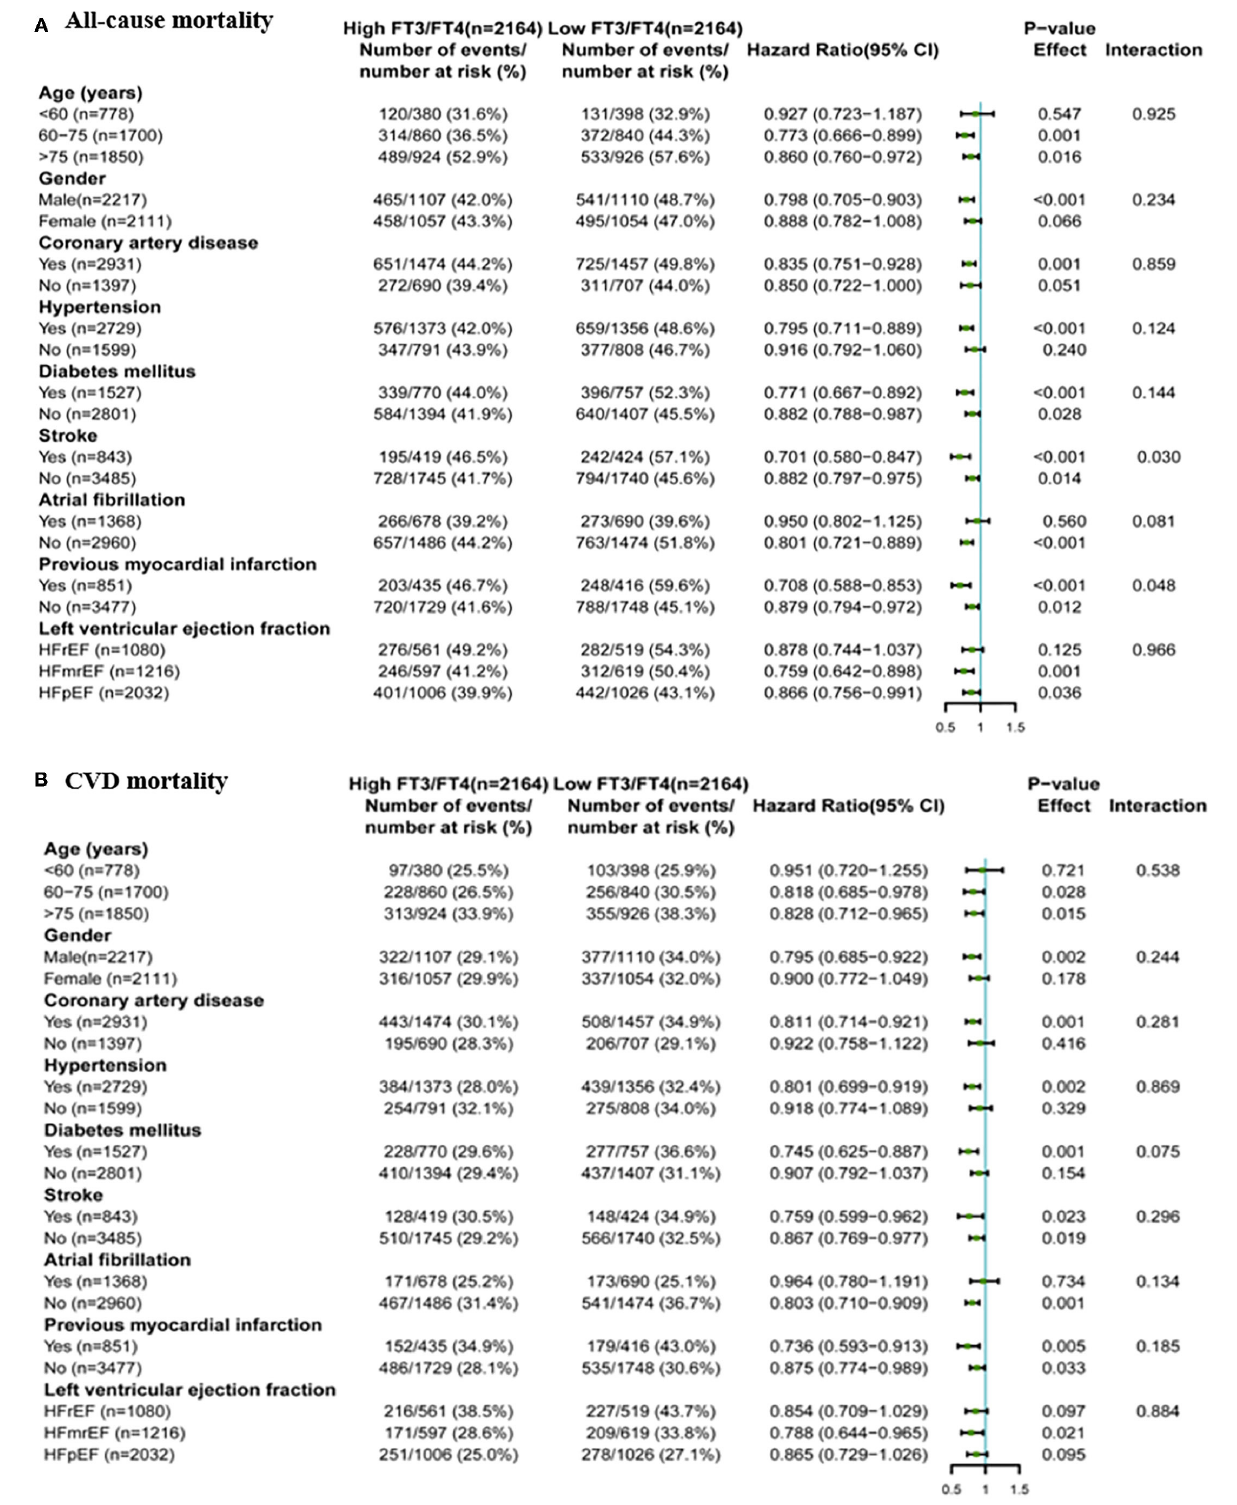
Frontiers in Cardiovascular Medicine |